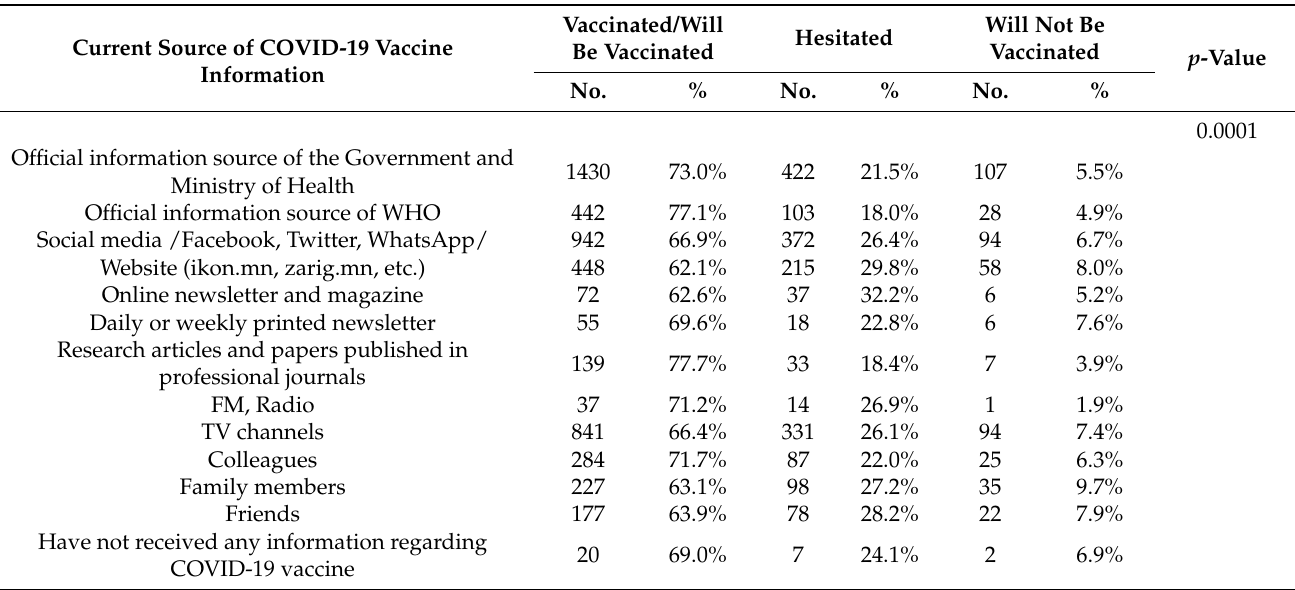
Table 5. Details of the respondents’ willingness to be vaccinated for COVID-19 compared to the source of COVID-19 vaccine